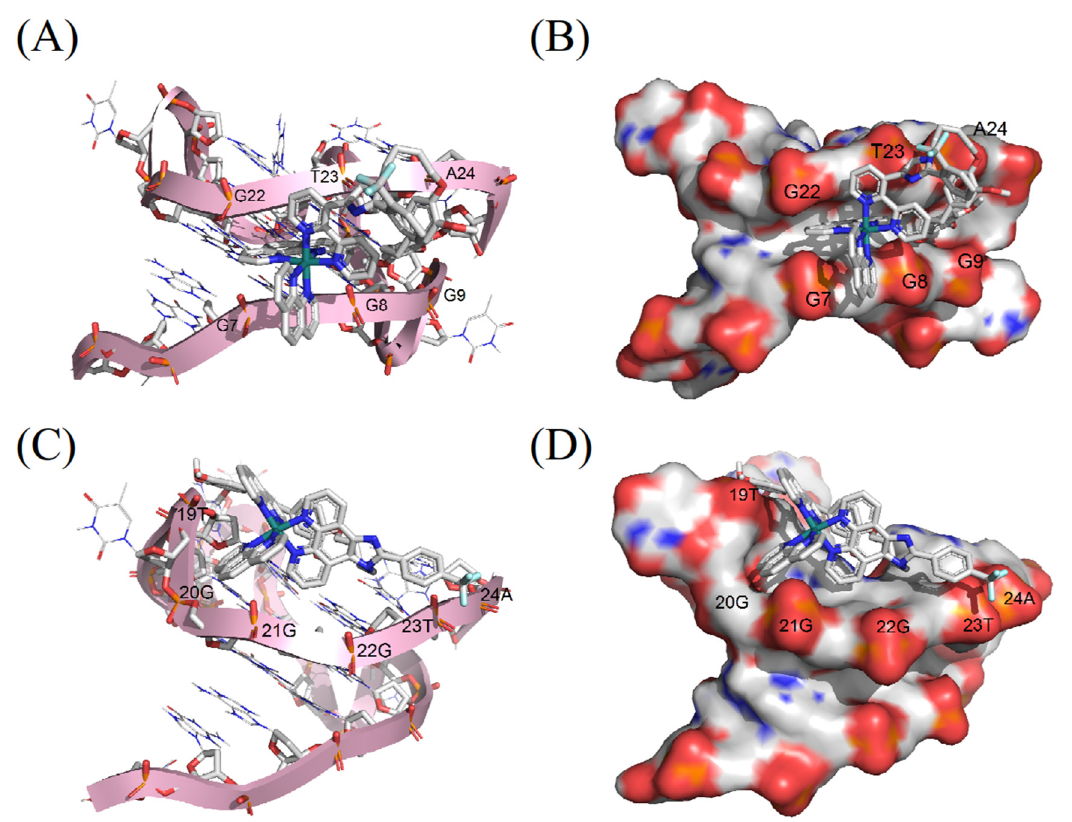
Figure 7. Molecular docking of 1 ( A , B ) and 2 ( C,D ) into c-myc G-quadruplex DNA.